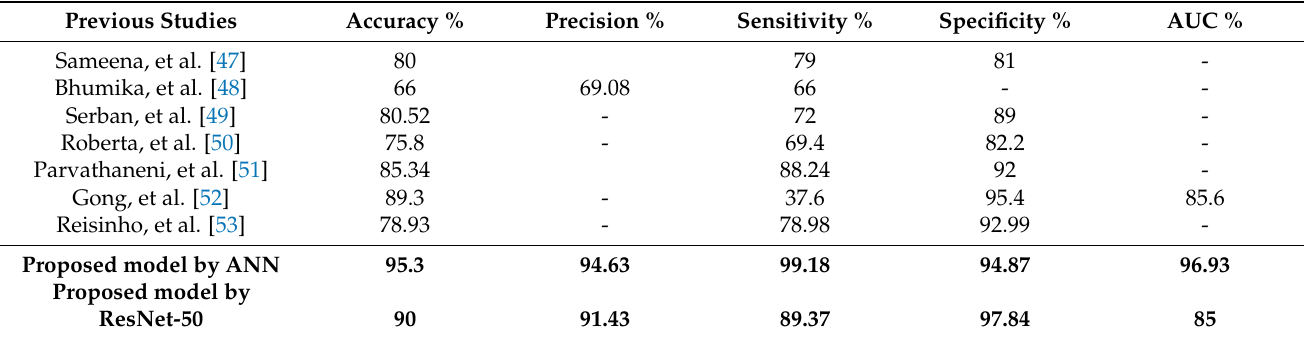
Table 8. Comparison of the performance of the proposed systems with the existing systems. Previous